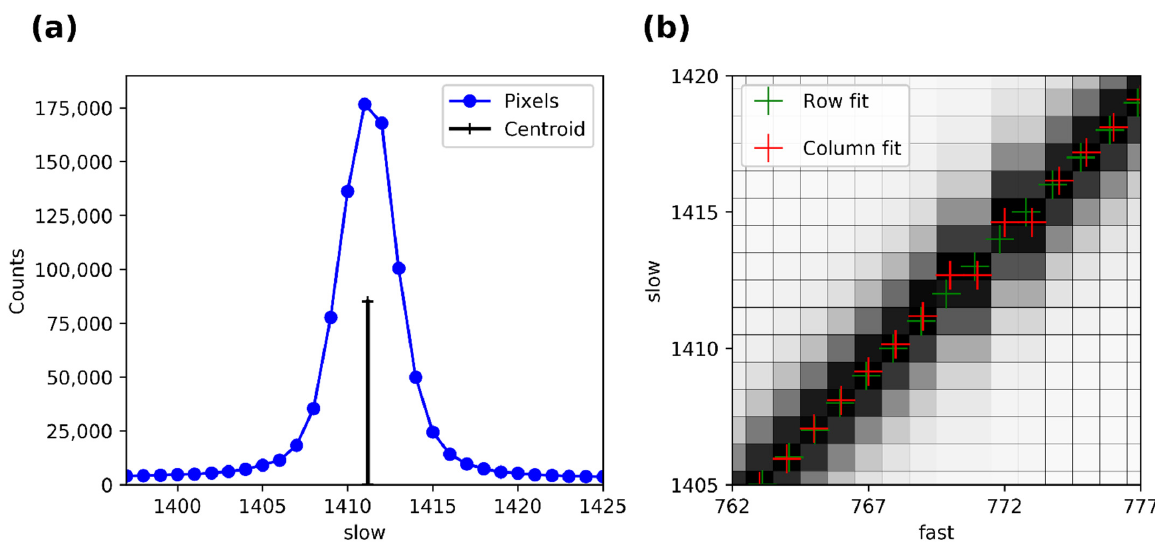
Figure 2. ( a ) Photon counts and peak position for a single column of pixels. ( b ) A region of interest on the detector where columns 770–773 show the effects of a virtual pixel correction at the edge of a physical readout chip. Slow and fast labels refer to the pixel directions in the image.